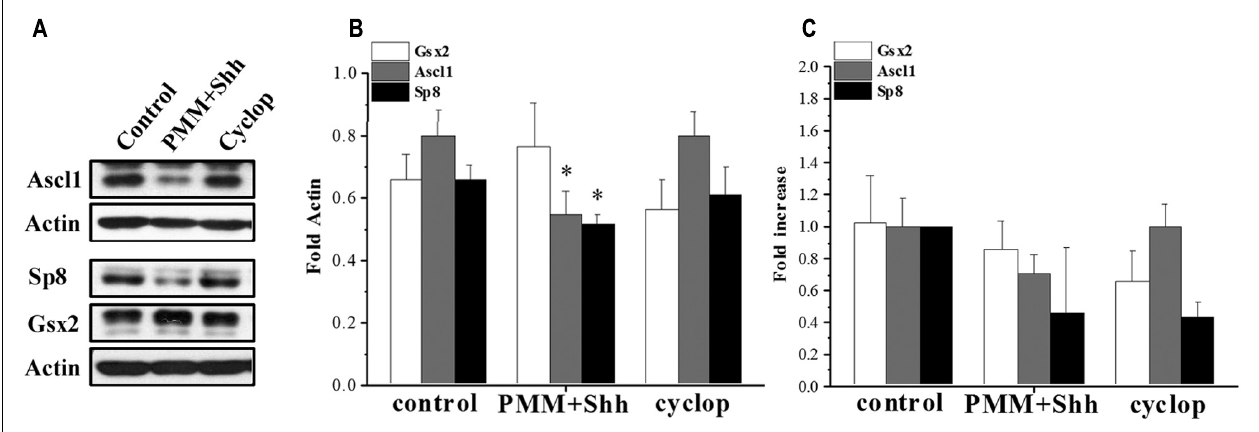
FIGURE 5 | Effect of Shh signaling on Gsx2,Ascl1, and Sp8 in cortical RGC cultures after 7 DIV. (A) Representative immunoblots and (B) quantification on the protein expression and (C) mRNA levels after treatment with PMM/Shh and cyclopamine. * p < 0.05, t -test.